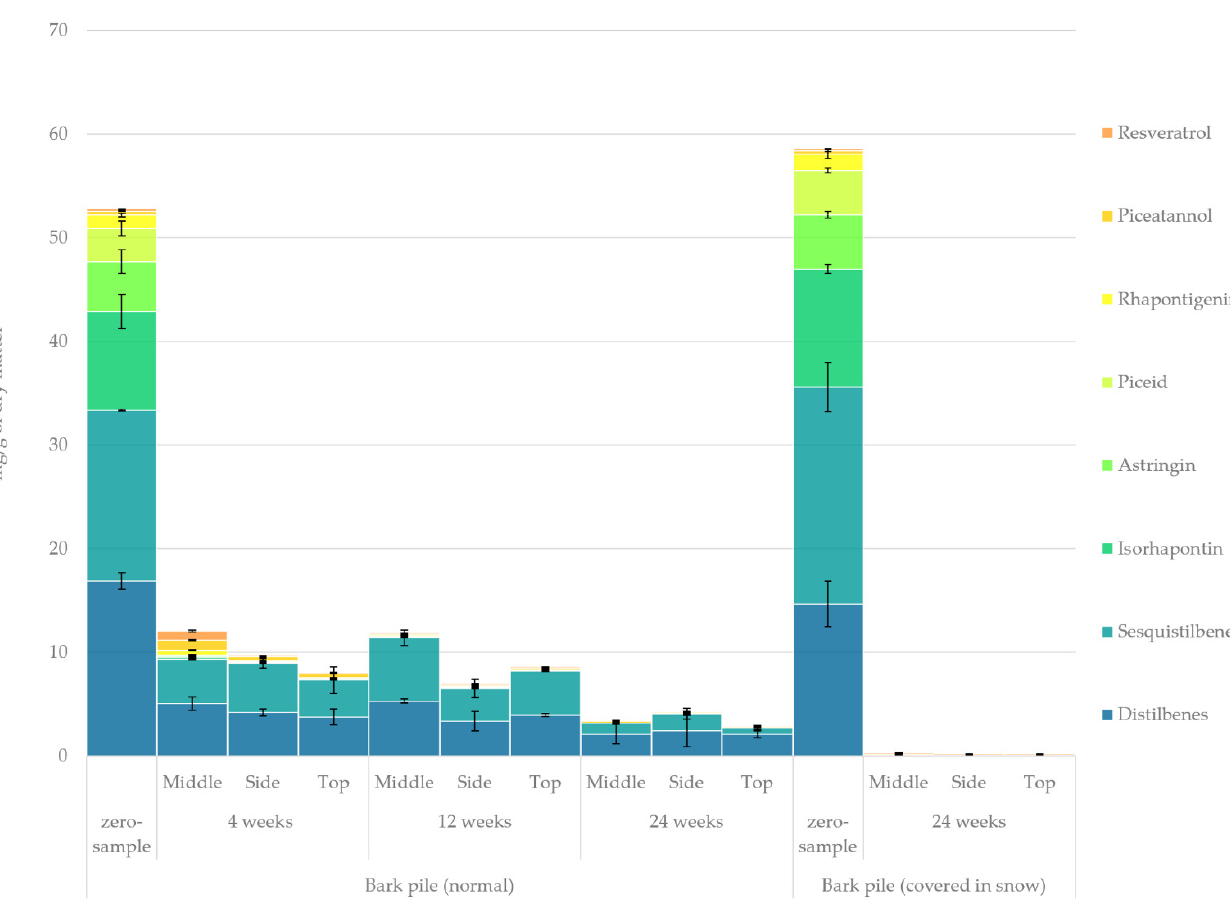
Figure 12. Quantified amounts of stilbenoids in the hydrophilic extracts of stored bark.